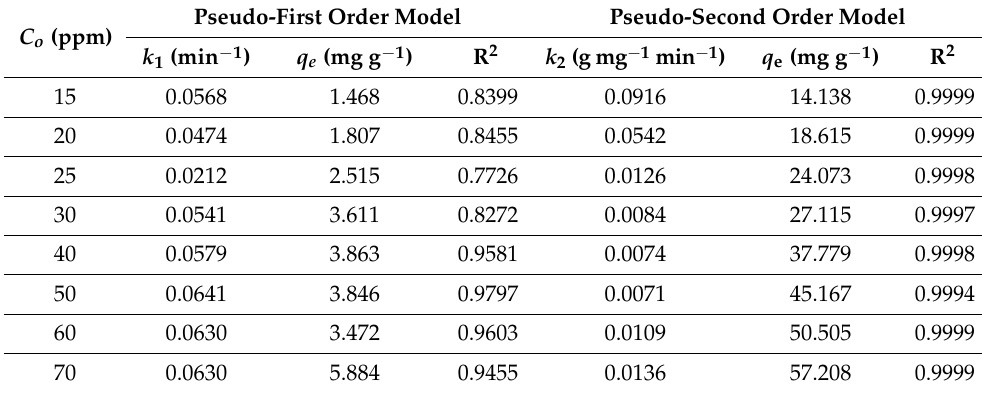
Table 4. The kinetic parameters calculated from the pseudo first- and the second-order models.